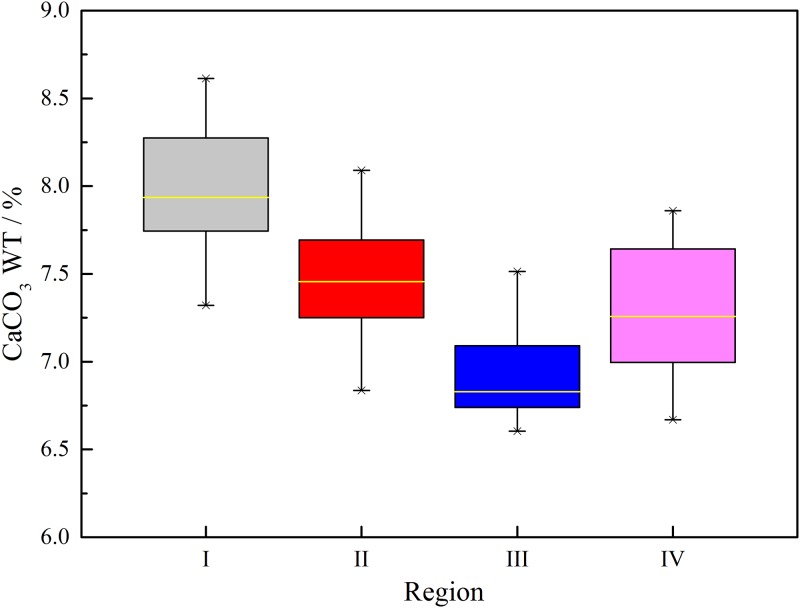
Box plot for CaCO3 content of the specimen after healing at OD600 0.9.